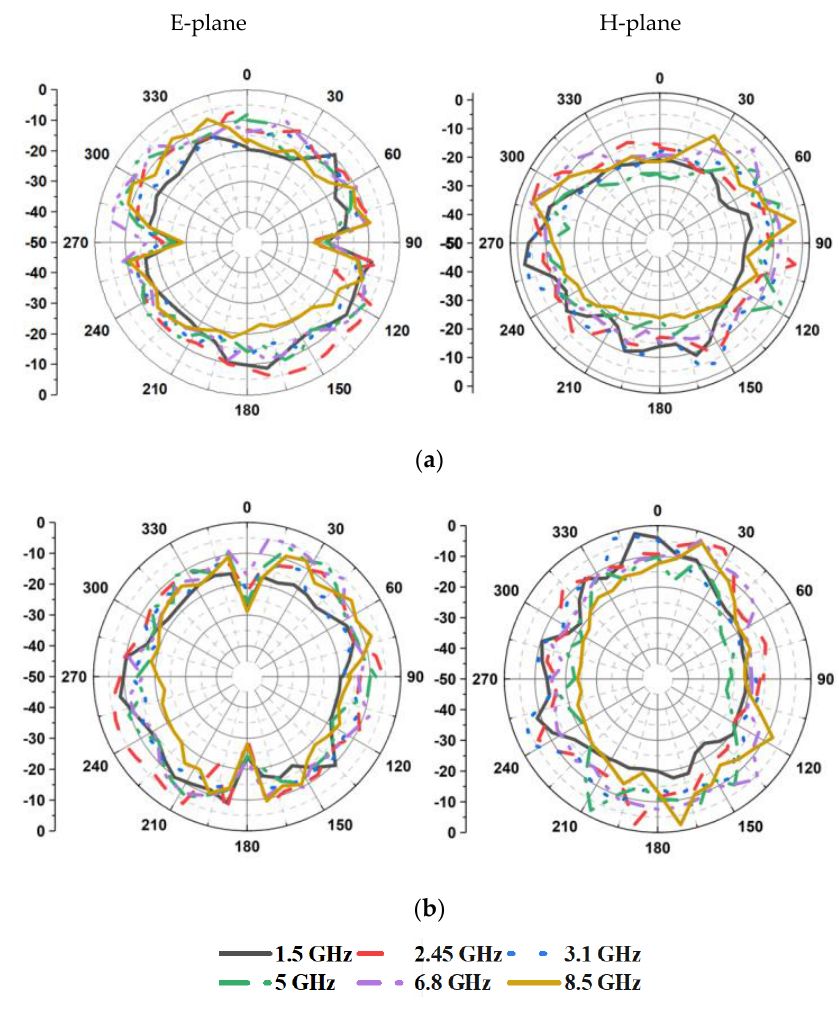
Figure 12. Measured radiation patterns of the antenna: ( a ) when port 1 is excited, ( b ) when port 2 is excited.